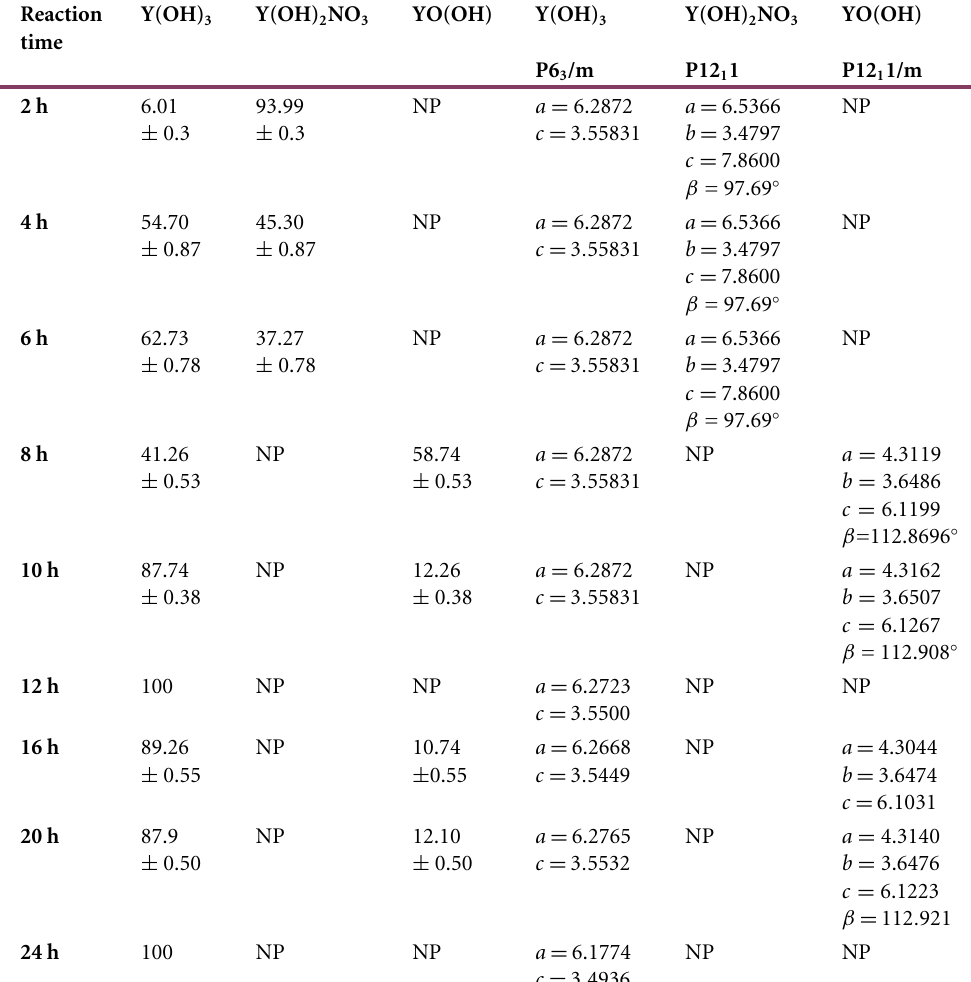
Table 1 Phase composition estimated by Rietveld refinement